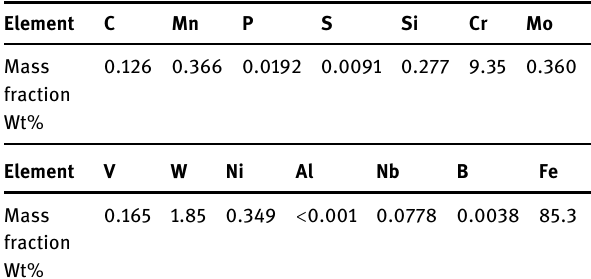
Table 1: Chemical composition of an as - received P92 steel sample (